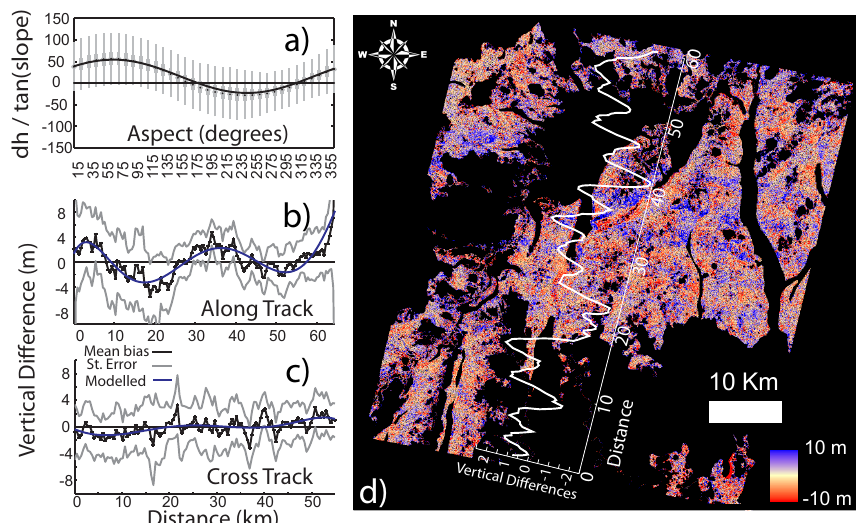
Fig. 5. (a) , (b) and (c) show the first three corrections applied between two ASTER SilcAst DEMs from 2006 and 2002. (d) Shows the resulting elevation differences with a plot of the mean elevation differences along track. The linear cross-track features that run along track seem to have an amplitude of 1–2m in the vertical direction. These fluctuations are thought to be induced by unrecorded pitch variations of the satellite, jitter